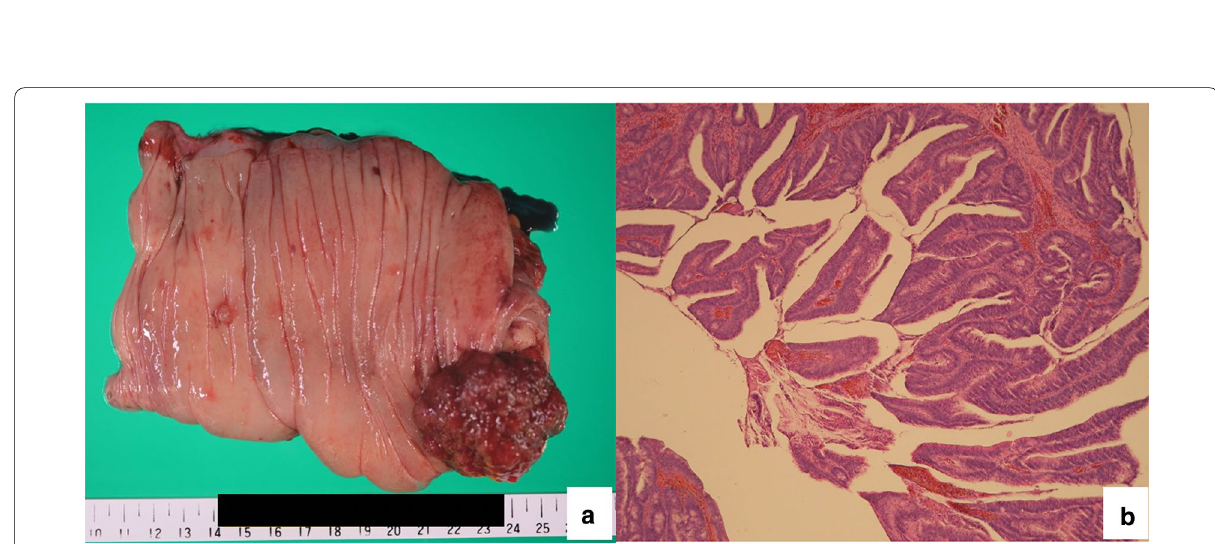
Fig. 5 Resected specimen and histopathological images. a The tumor is reddish, round, elastic soft, granular surfaced, measuring 45 mm in length and 40 mm in width in the cecum. b The lesion is stained with hematoxylin and eosin (magnification: 200